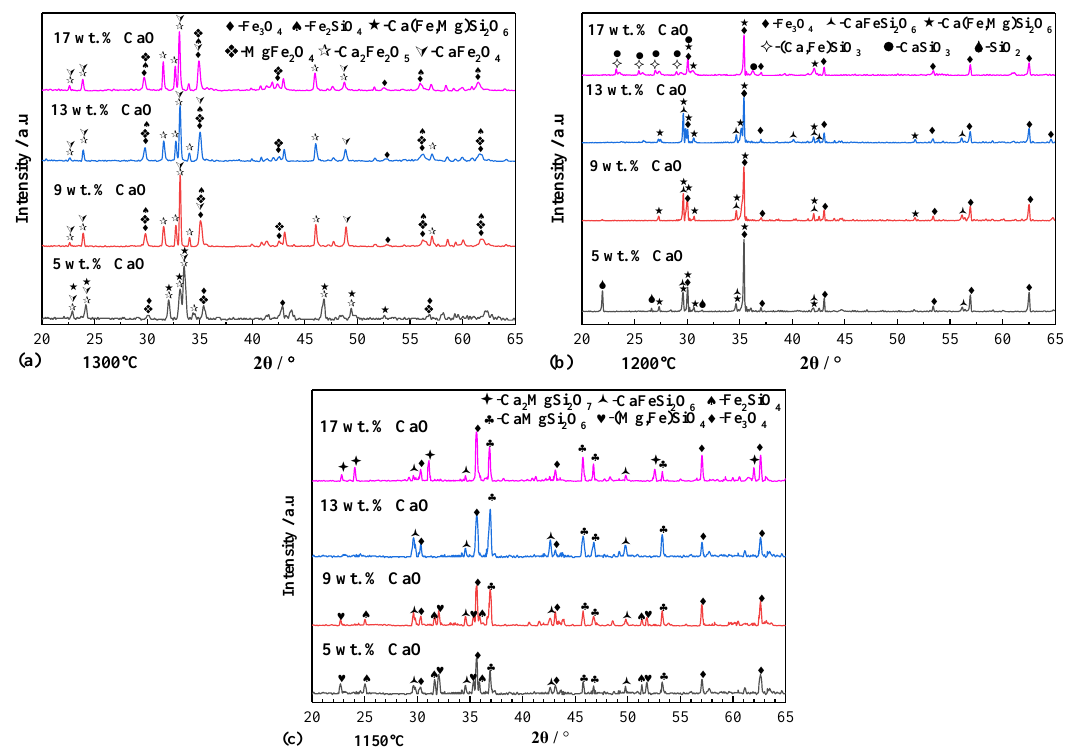
Figure 7. XRD di ff raction patterns of water quenched nickel slag with di ff erent CaO contents ( a ) Figure 7. XRD diffraction patterns of water quenched nickel slag with different CaO contents ( a ) 1300 1300 ◦ C; ( b ) 1200 ◦ C; ( c ) 1150 ◦ °C; ( b ) 1200 °C; ( c ) 1150 °C.